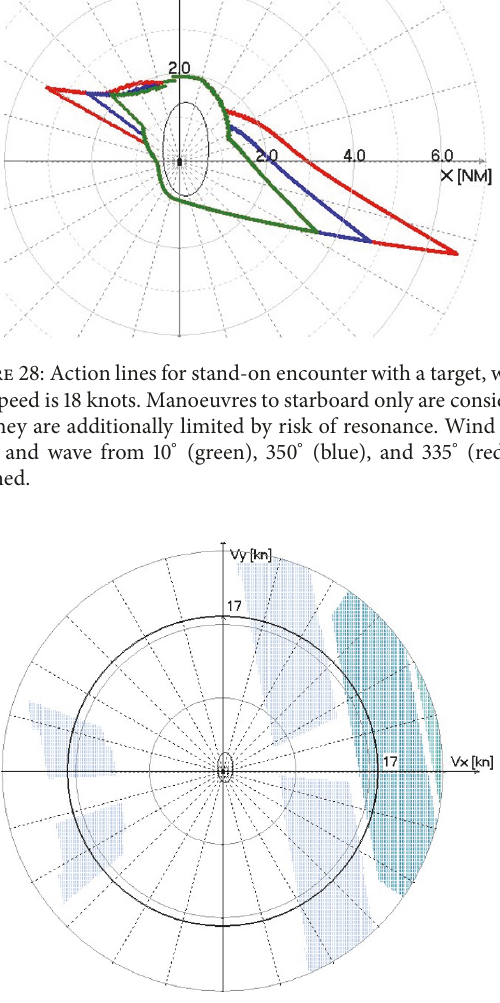
Figure 29: Sectors of own course and speed eliminated by risk of successive high wave attack (turquoise) and resonance (light blue) for wind of 17 [m/s] and wave from 260 ∘